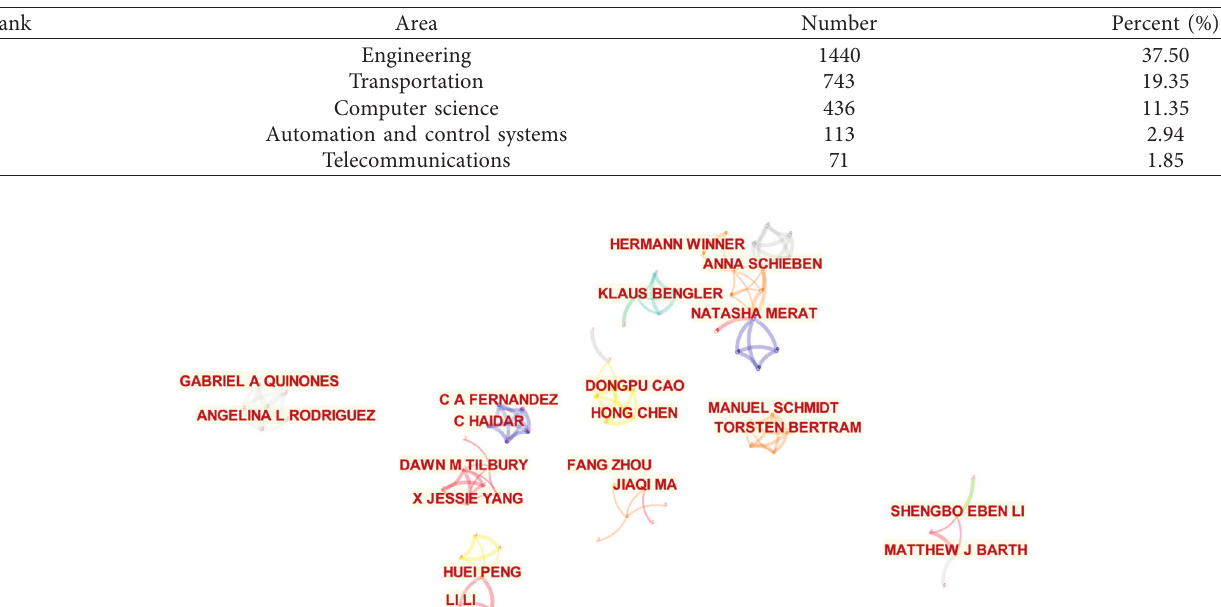
Figure 6: Author collaboration network. Table 5: Number of articles published by